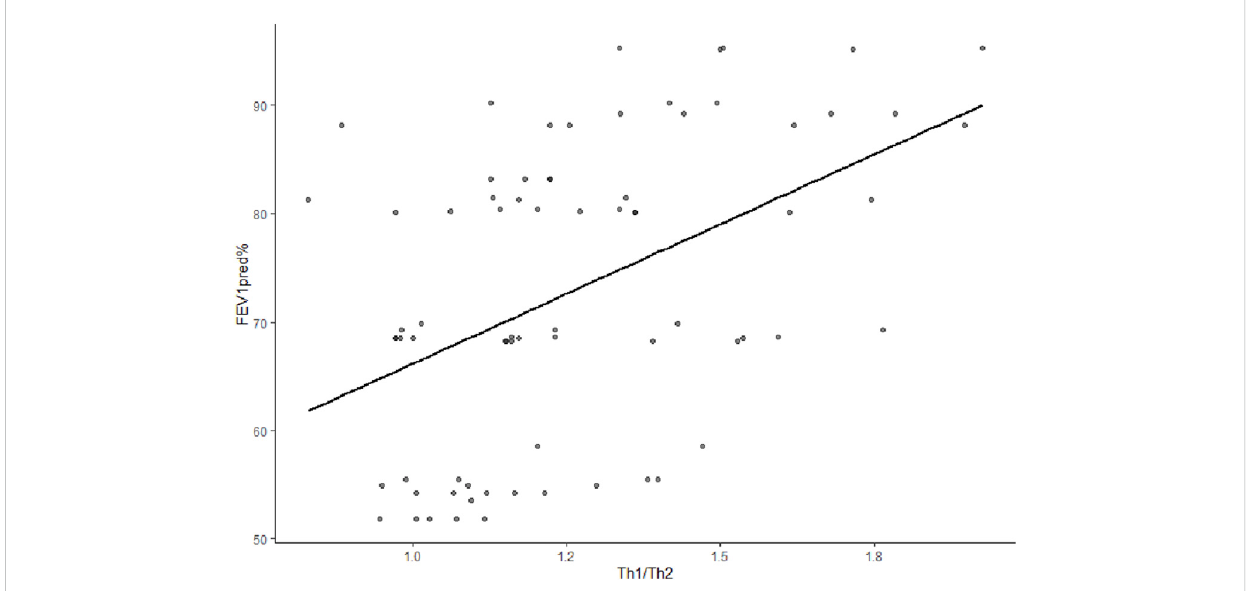
Correlation analysis between Th1/Th2 cytokines and FEV1pred% in early COPD. The r (correlation coef fi cient) was 0.485( p < 0.001), indicating a positive correlation between Th1/Th2 cytokines and FEV1pred%.